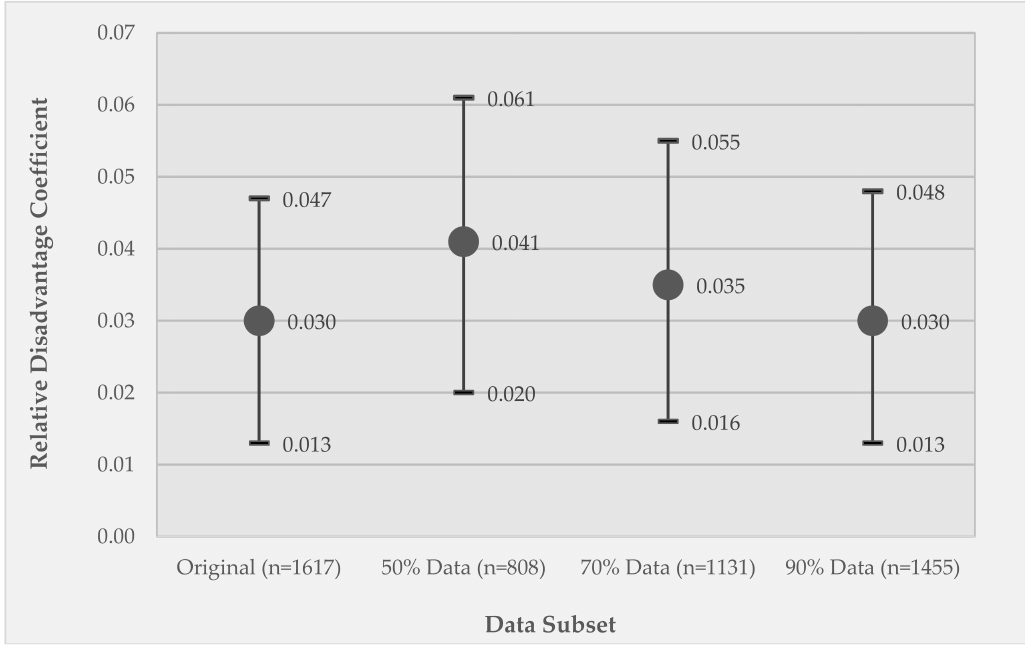
Figure 3. Results for the listwise deletion data sets for Model 1, GEE coefficients of the effect of relative disadvantage on momentary stress. Coefficients are reported for the original data set (100% retained) and each data subset—50% retained, 70% retained, and 90% retained subsets of the original data set. Circle markers represent coefficient values; whiskers represent 95% confidence intervals. All coefficients are significant at p <